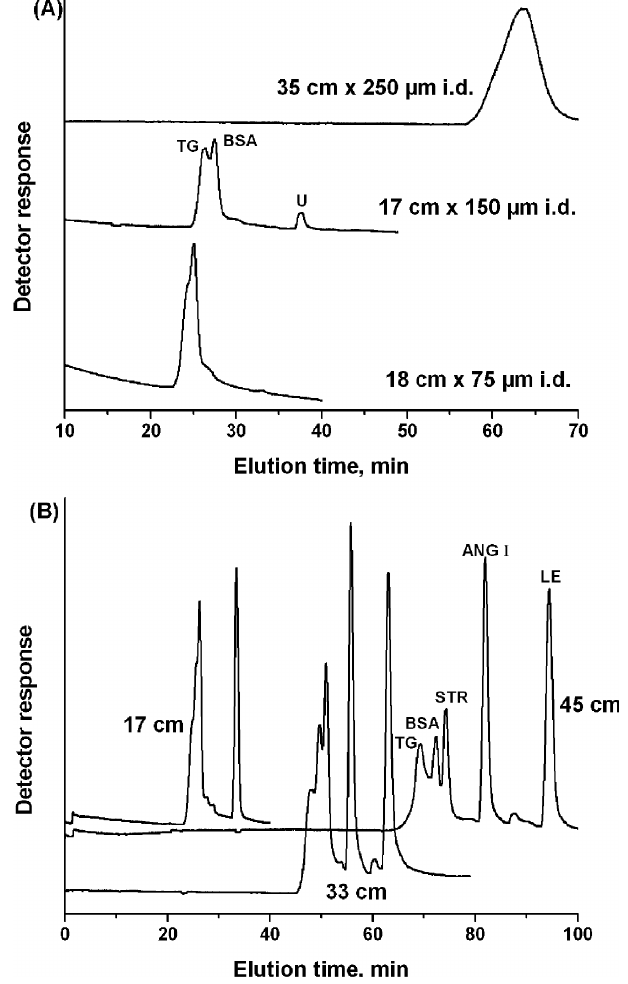
Figure 12. SEC separation on methyl ether acrylate monolith using different column lengths ( A ) and diameter ( B ). Mobile phase was 20 mM phosphate with NaCl. Key: TG: Thyroglobulin; BSA: Albumin; STR: Trypsin Inhibitor; ANG1: Angiotensin 1; LE; Leucine encephalin. Reprinted with permission from [155], Copyright (2009), American Chemical Society.